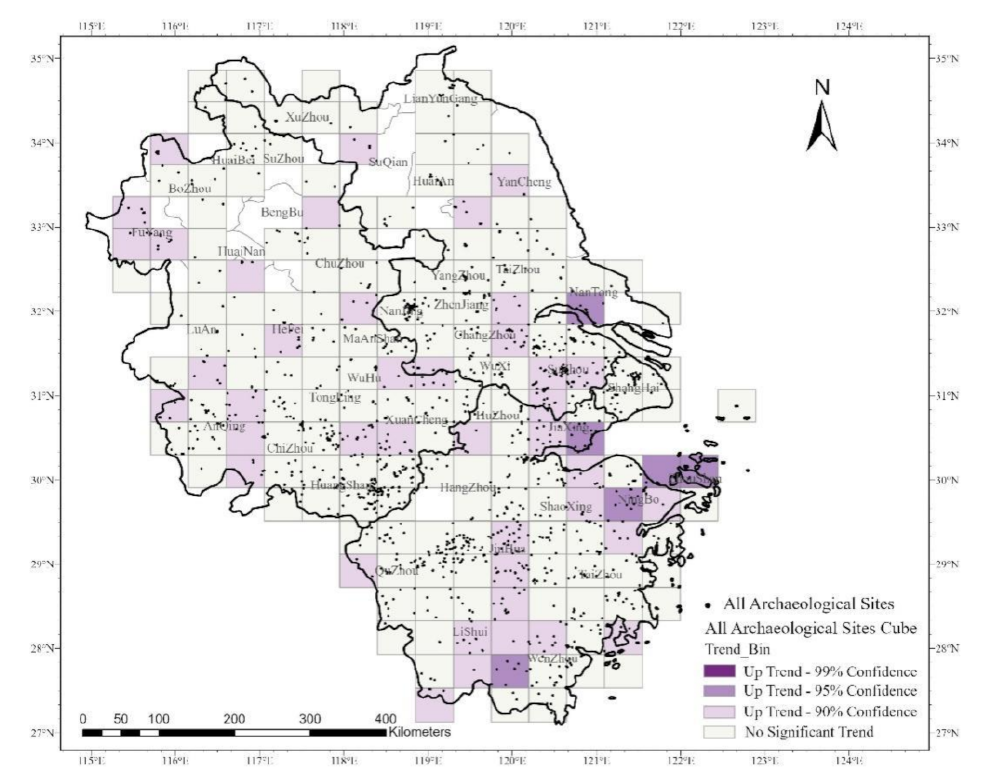
Figure 10. The space-time cube trend analysis of Archaeological Sites. As can be seen from the figure, the purple region is the time series of the Archaeological Sites’ data bars with an upward trend. Among 189 data cube locations of Archaeological Sites, 47 data cube locations of Archaeological Sites showed an upward trend. On the whole, these upward trending space-time cube bars are mainly distributed in the marginal areas and some central areas, and it shows that the distribution of Archaeological Sites in these areas is increasing in time and space. Among them, belonging to Anhui Province, there were 17 spatio-temporal columns, accounting for 29.79%. Belonging to Jiangsu Province, there were 9 spatio-temporal columns, accounting for 19.14%, and belonging to Zhejiang province, there were 21 spatio-temporal columns, accounting for